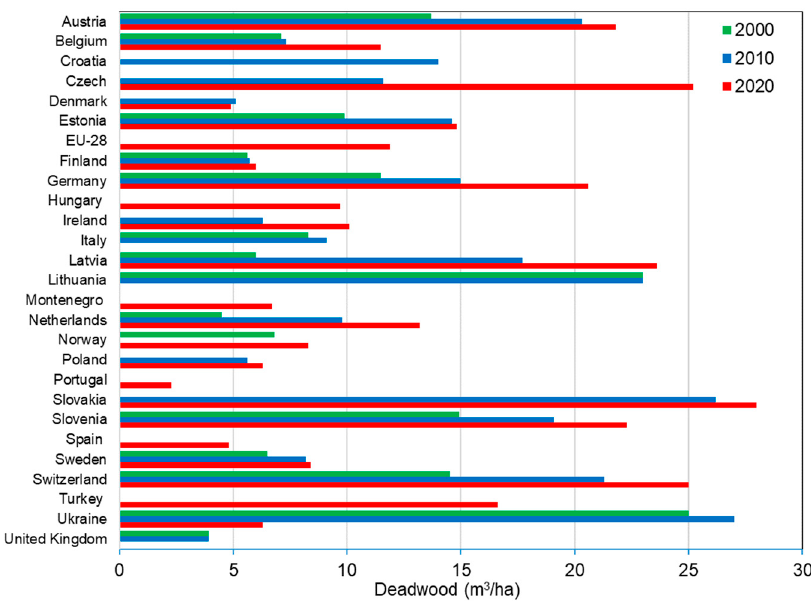
Figure 2. Average volumes of deadwood in European countries, 2000–2020 [2 ,3].